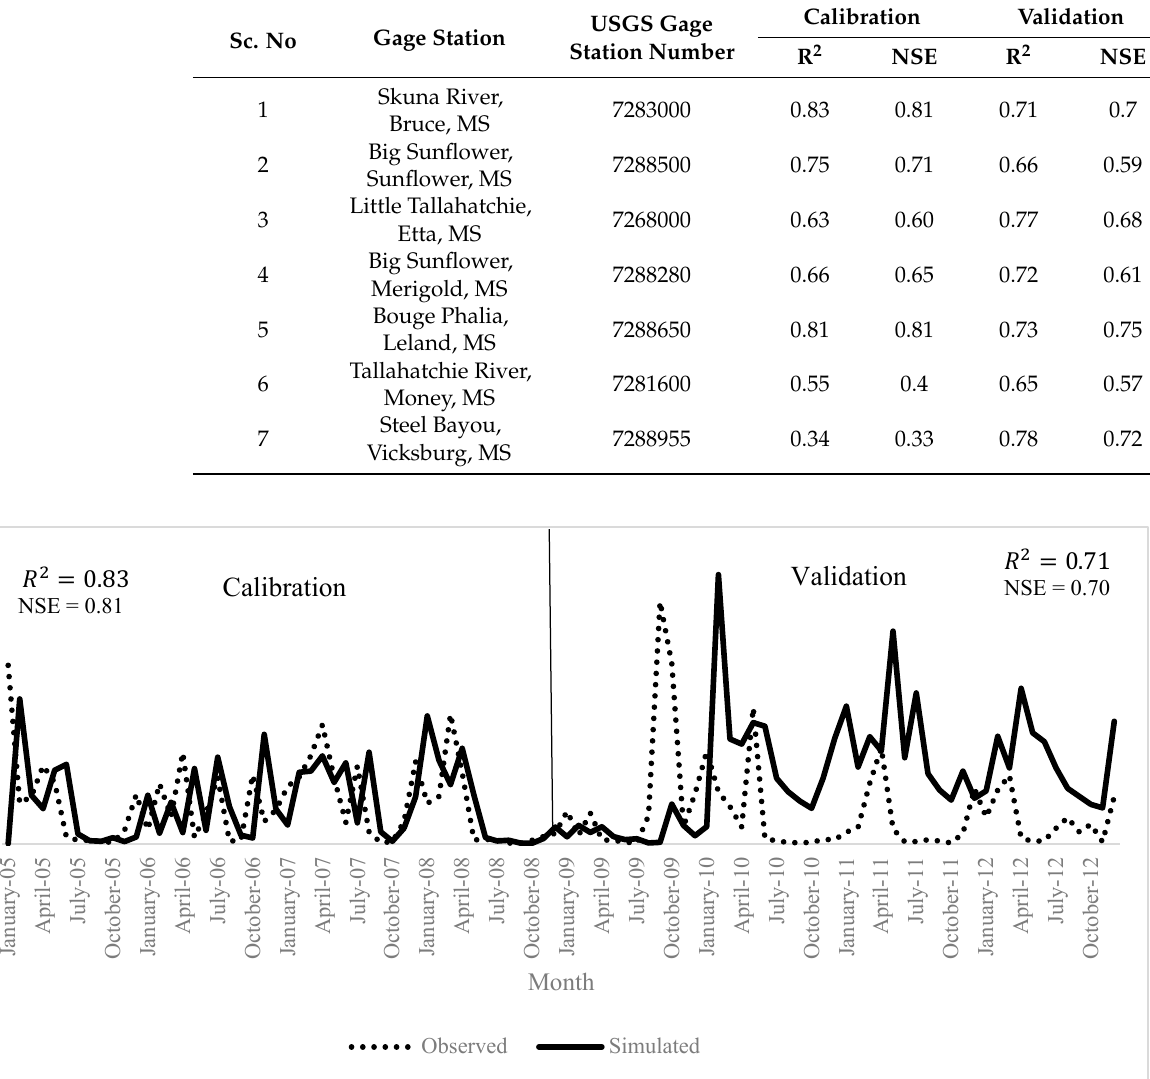
Table 3. Streamflow calibration and validation from 7 gage stations in the watershed.